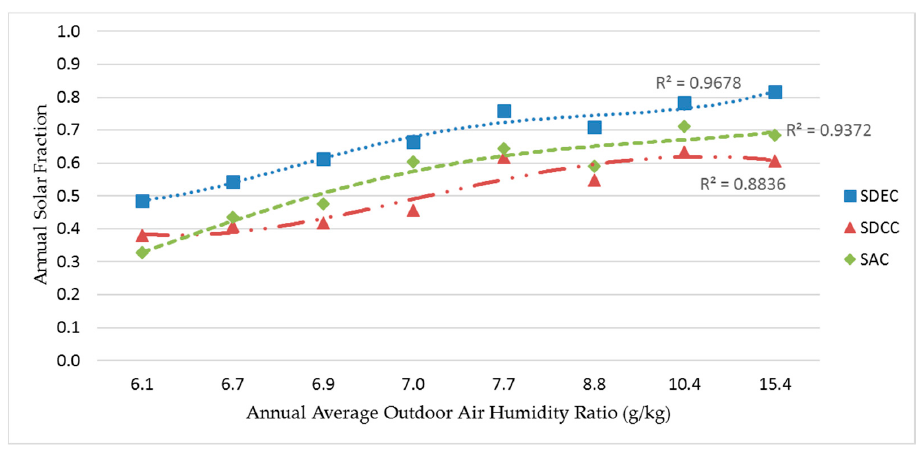
Figure 14. Correlation between outdoor air humidity ratio and annual SF .